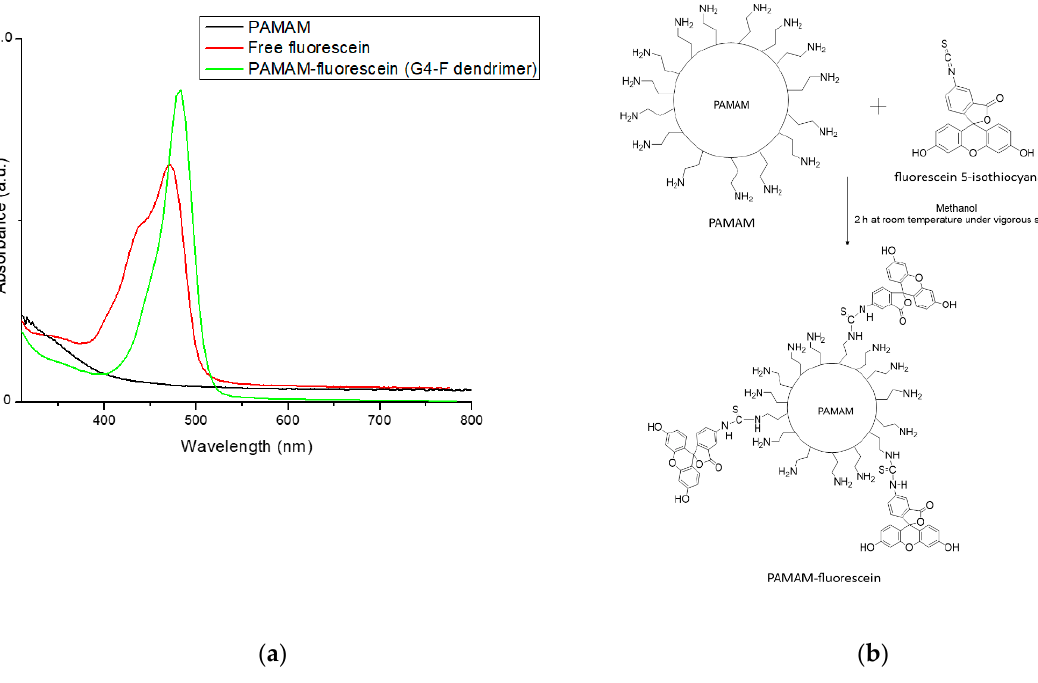
Figure 1. ( a ) UV-visible spectra of unmodified PAMAM, free fluorescein, and PAMAM functionalized with fluorescein. ( b ) Illustration of the chemical reaction and experimental conditions for the synthesis of PAMAM functionalized with fluorescein.